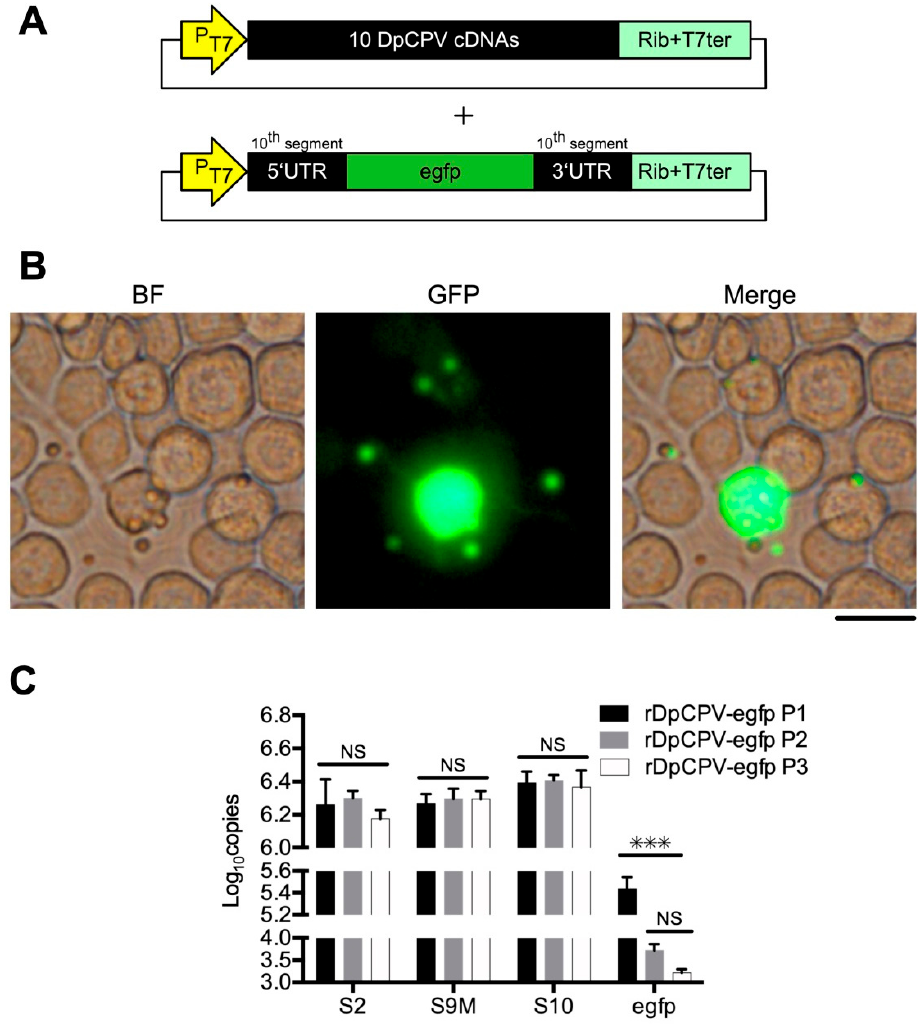
Figure 5. Generation and identification of DpCPV-egfp containing an egfp gene flanked with the 5 (cid:48) and 3 (cid:48) UTR of the 10th genomic segment. ( A ) Schematic representation of the T-S10UTR-egfp vector in which the ORF of the DpCPV S10 genome was replaced with the egfp gene. T-S10UTR-egfp was mixed with three DpCPV constructs which contained the 10 DpCPV cDNAs. ( B ) Sf9 cells were transfected with the three DpCPV constructs (pBS-S10-S7-S1-S9M, pBS-S6-S5-S3 and pBS-S8-S4-S2), AcBac-T7pol- ∆ vp80 and an extra vector T-S10UTR-egfp to generate rDpCPV-egfp. Images were obtained by fluorescence microscopy with 488-nm light excitation at 7 days post-transfection. OBs were observed, and some OBs co-localized with green fluorescence. Scale bars, 10 µ m. ( C ) The rDpCPV-egfp successively infected S. exigua larvae for three generations and the copy numbers of the S2, S9, S10 and egfp genes in equivalent numbers of OBs were determined by RT-qPCR. With passaging, there was no significant change in the copy numbers of the S2, S9 and S10 genes, while the copy number of egfp in the P2 and P3 generations was significantly lower than in the P1 generation (NS indicates p > 0.05, *** indicates p < 0.001, Tukey’s multiple comparison post F test).